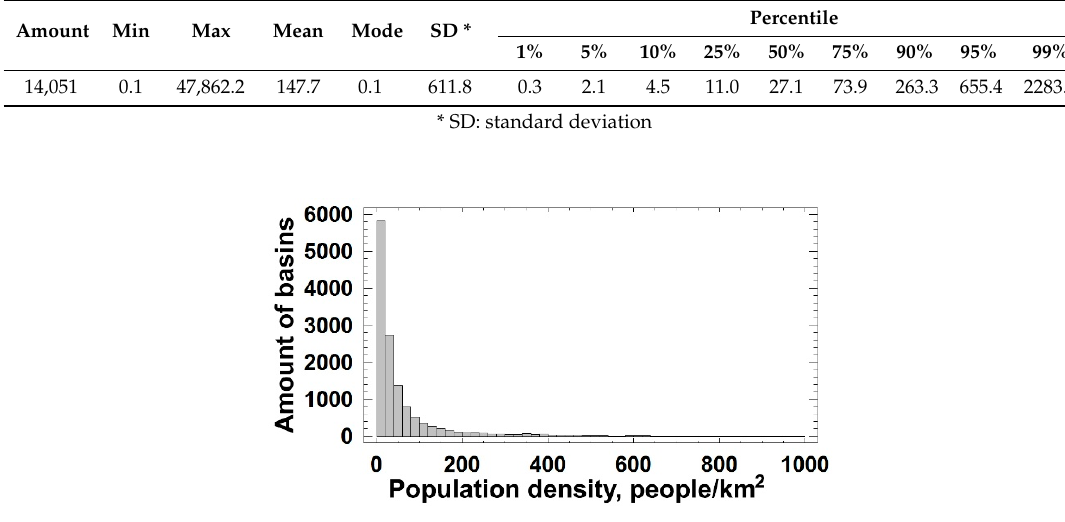
Figure 5. The distribution of basins in terms of population density. Table 2. Main statistics of population density in the basins.